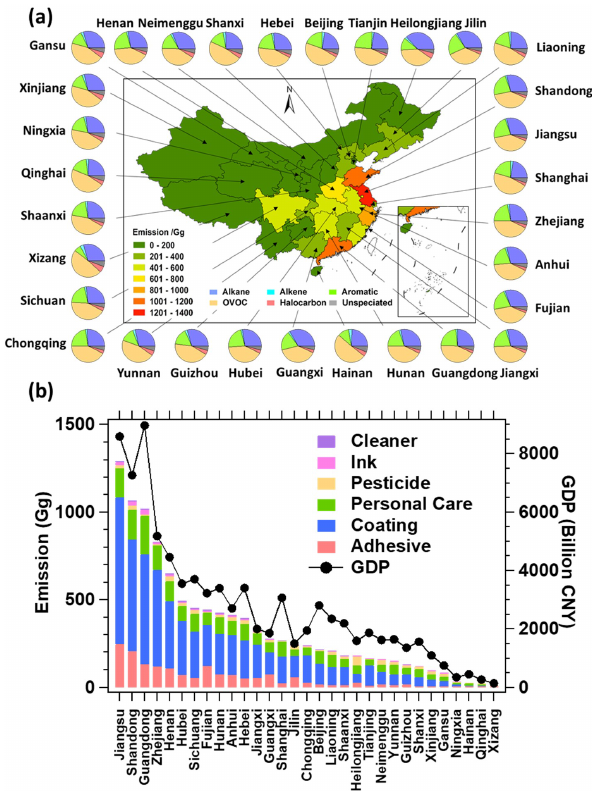
Figure 3. (a) Spatial distributions of solvent use NMVOC emissions in China and (b) their source contributions in different provinces in